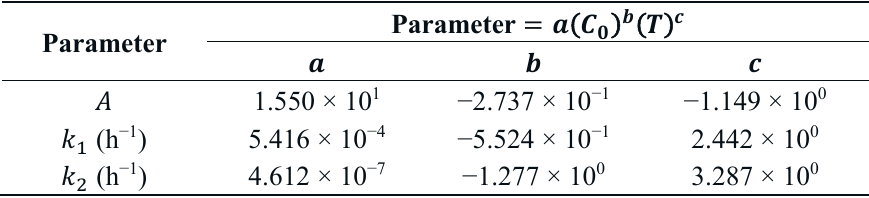
Figure 6. Multivariate function resulting from regression for chlorine parameter (cid:1863) Table 1. Coefficient and exponents obtained for chlorine using multivariate regression analysis.